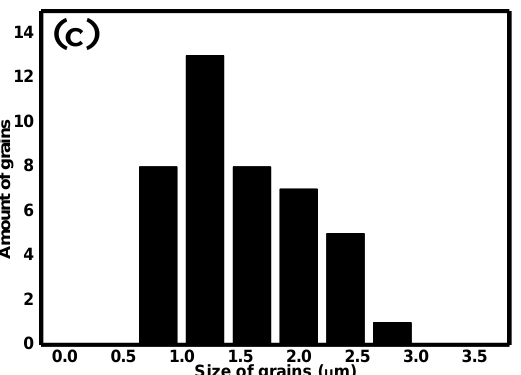
Figure 4. ( a ) SEM images (10 K magnification) and EDX plot, ( b ) illustration of the top half of grain, and ( c ) grain size distributions of Sr 2 CaTeO 6 .